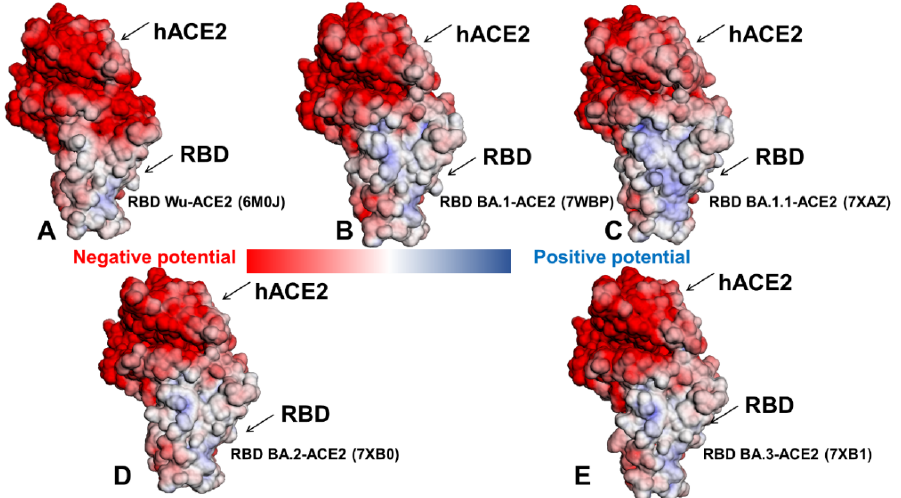
Figure 6. The distribution of the electrostatic potentials calculated with the APBS method [83,84] on the molecular surface of the S-RBD Wu-Hu-1 complex with hACE2, pdb id 6M0J ( A ), S-RBD Omicron BA.1 complex with hACE2, pdb id 7WBP ( B ), S-RBD Omicron BA.1.1 complex with hACE2, pdb id 7XAZ ( C ), S-RBD Omicron BA.2 complex with hACE2, pdb id 7XB0 ( D ), and S-RBD Omicron BA.3 complex with hACE2, pdb id 7XB1 ( E ). The color scale of the electrostatic potential surface is in units of kT/e at T = 37 ◦ C. Electro-positively and electronegatively charged areas are colored in blue and red, respectively. Neutral residues are in